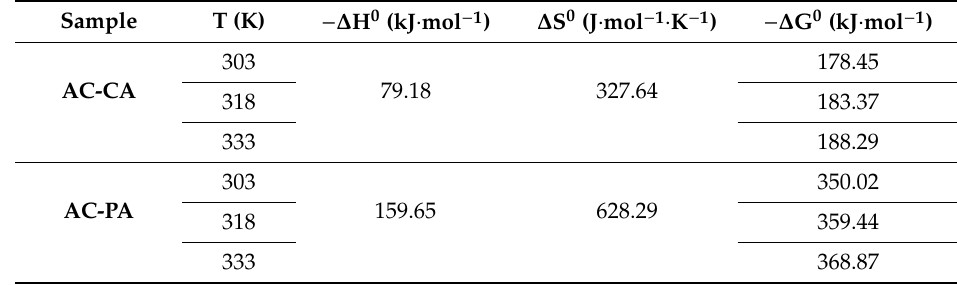
Table 4. Calculated thermodynamic kinetics parameters for both activated carbons